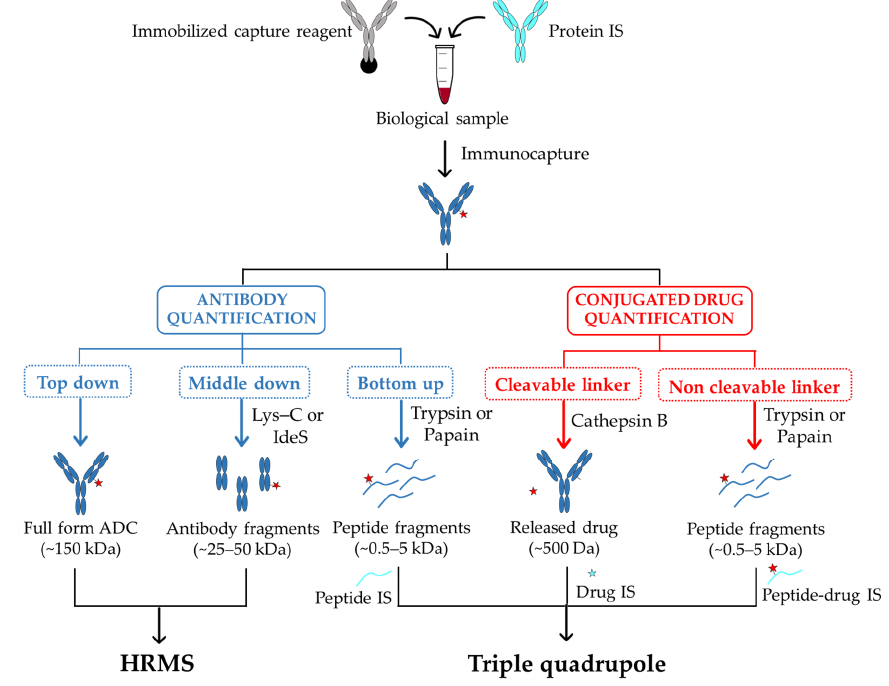
Figure 2. A typical workflow for the bioanalysis of ADCs in biological sample using LB-LC–MS / MS methods. The antibody and the peptide fragments are colored in blue, the free drug and its metabolites are represented as red stars. The internal standards, Peptide IS and Peptide-drug IS, are colored in cyan. The Drug IS is represented as a cyan star. IS: internal